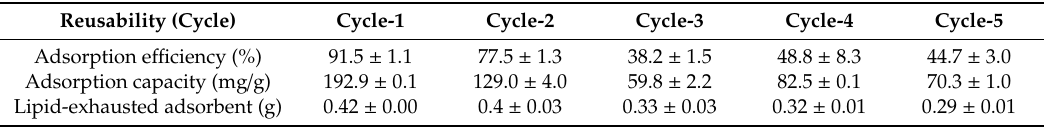
Table 3. Performance of spent sugarcane-bagasse-based adsorbent for reiterative removal of microalgal biomass via adsorption-enhanced flocculation